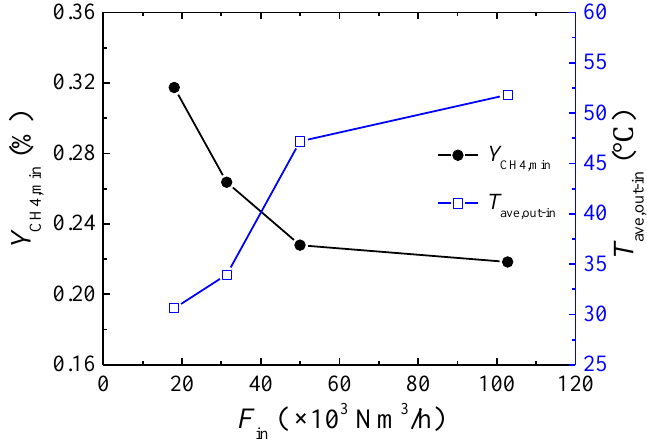
Figure 8. The lower concentration limit ( Y CH4,min ) and average outlet-inlet temperature difference ( T ave,out-in ) during self-maintained operation with different inlet flow rates ( F in ).